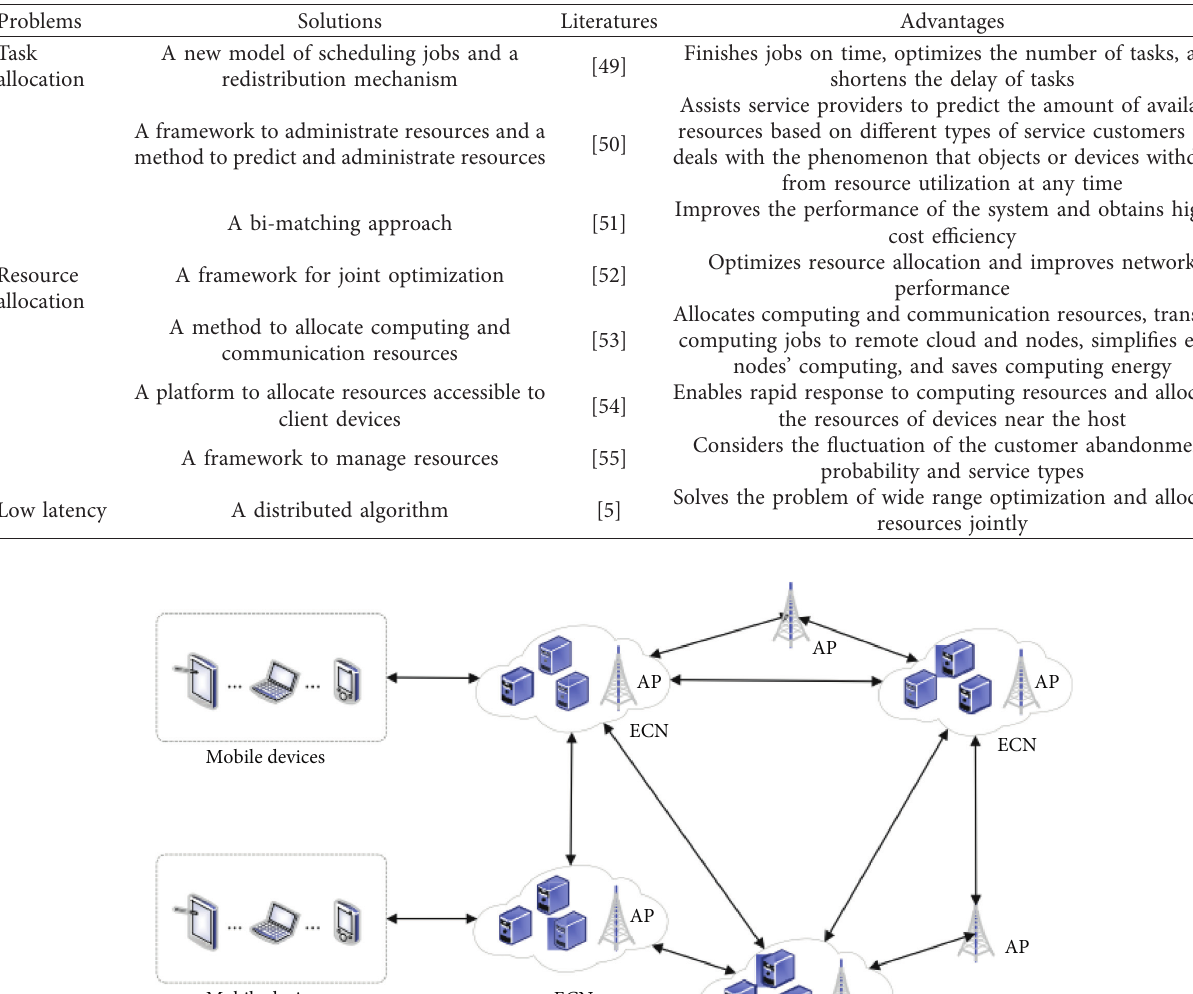
Table 3: Work summary of resource allocation and management in fog